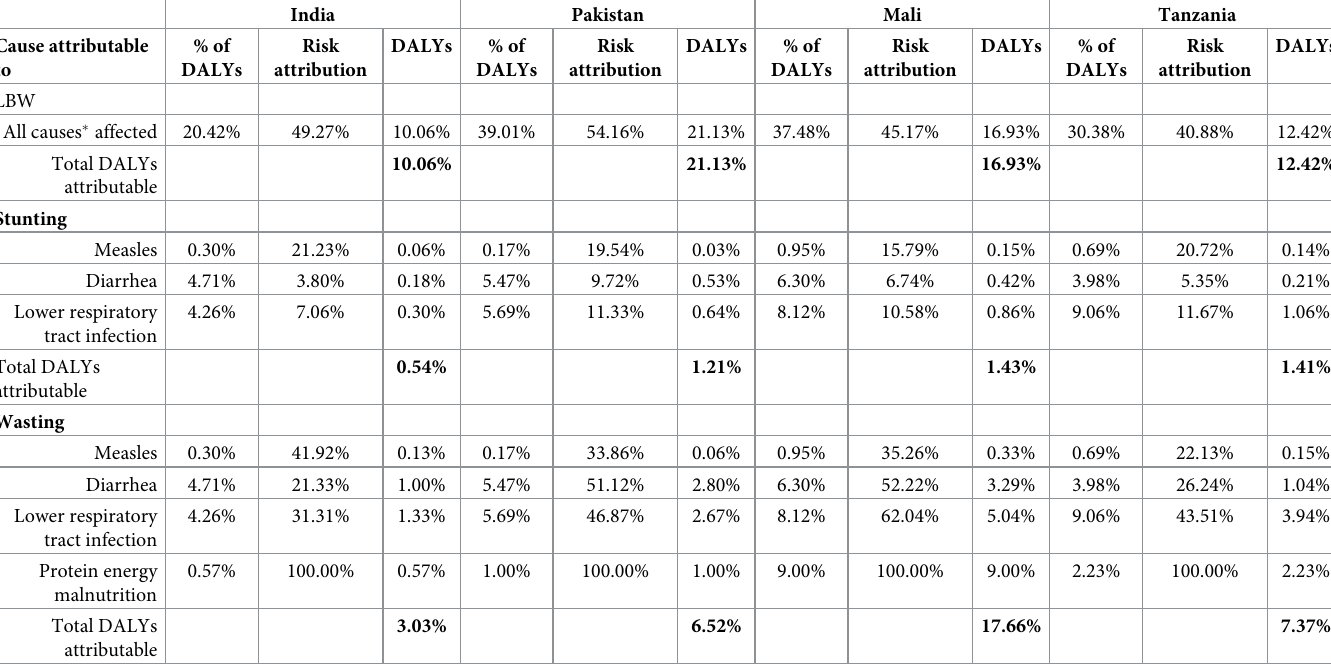
Table 4. Baseline DALYs attributable to modifiable risk factors among male and female children of under 2 years of age, 2017. India Pakistan Mali Tanzania Cause attributable to